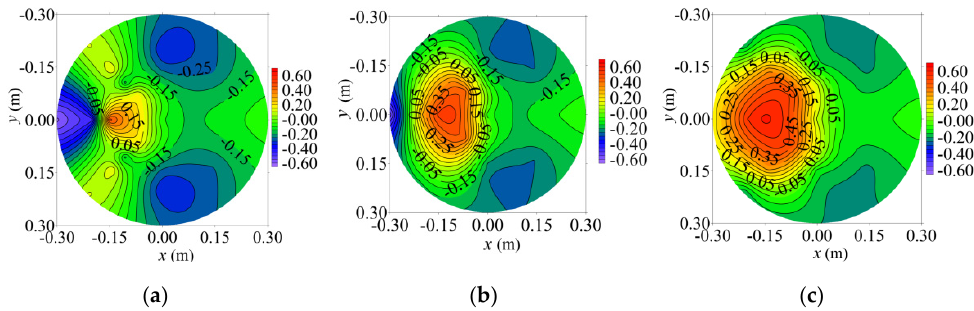
Figure 21. Contour maps of the maximum vertical wind velocity ( L = 0.5 D jet , H / h = 1/4): ( a ) r h = 0.8 D jet ; ( b ) r h = 1.0 D jet ; ( c ) r h = 1.2 D jet .